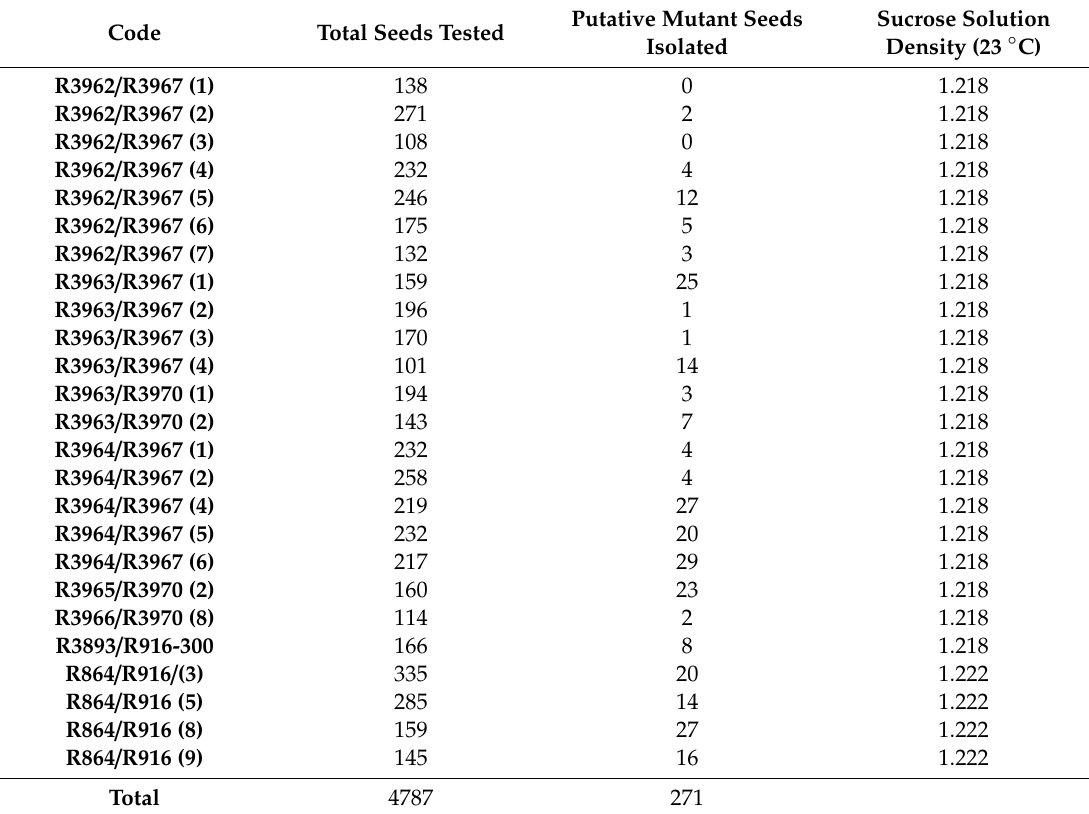
Table 1. Density assay on mutagenized F1 seeds obtained by crossing lpa1-1 / lpa1-1 (codes R3962 to R3966 and R3893 and R864) with Ac line (R3967, R3970 and